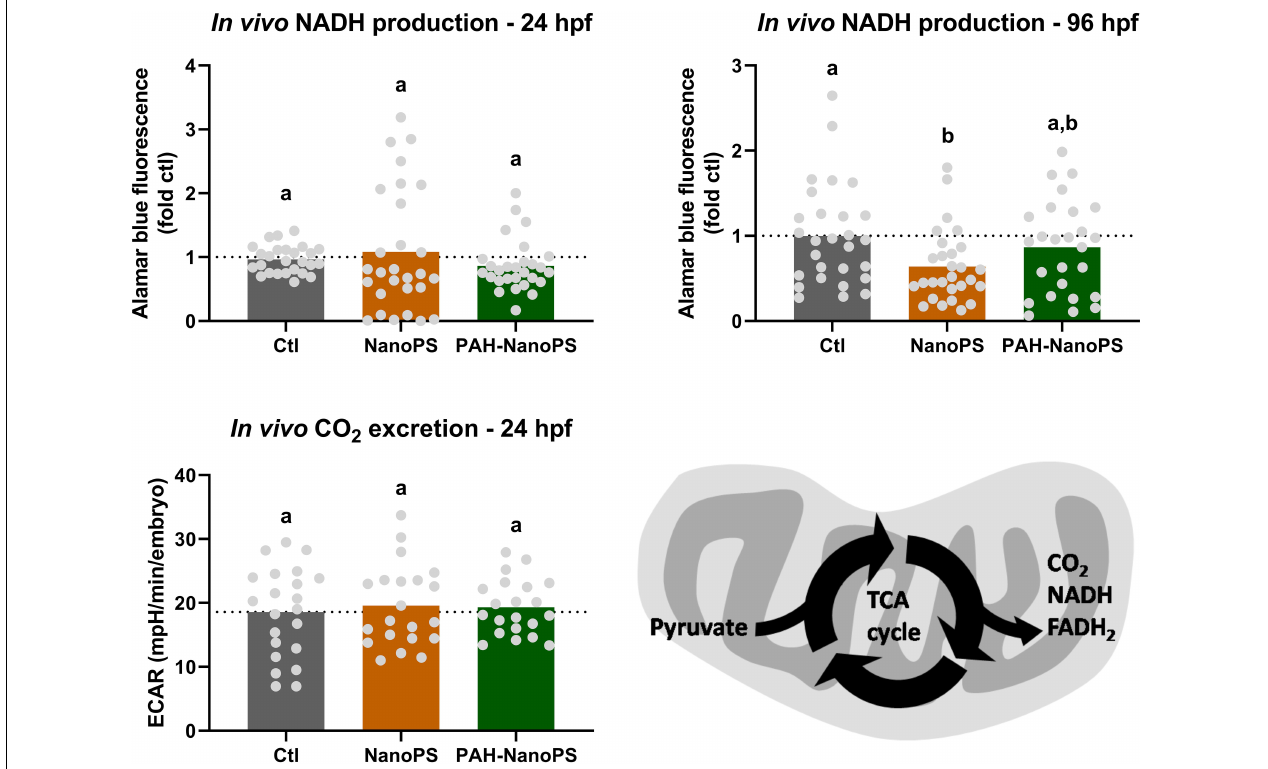
FIGURE 6 | Assessment of the TCA cycle through NADH production and CO 2 release in zebrafish embryos and larvae. Animals were exposed at 6 h post-fertilization (hpf) to 1 ppm polystyrene nanoparticles (NanoPS) or 1 ppm polystyrene nanoparticles with PAHs sorbed to their surface (PAH-NanoPS) (please see Figure 1 and section “Sorption of PAHs to the surface of NanoPS” for further details). In vivo NADPH production was estimated in 24 hpf embryos and 96 hpf larvae ( n = 26–28), while CO 2 release from the TCA cycle was analyzed only in 24 hpf embryos ( n = 21–22). The dotted line represents the average of the control group. The bottom right image indicates how NADH and CO2 productions can be indicative of the activity of the TCA cycle. Data were analyzed by one-way ANOVA followed by Tukey’s post-hoc or Kruskal-Wallis followed by Dunn’s post-hoc . Groups not sharing letters are significantly different ( p <